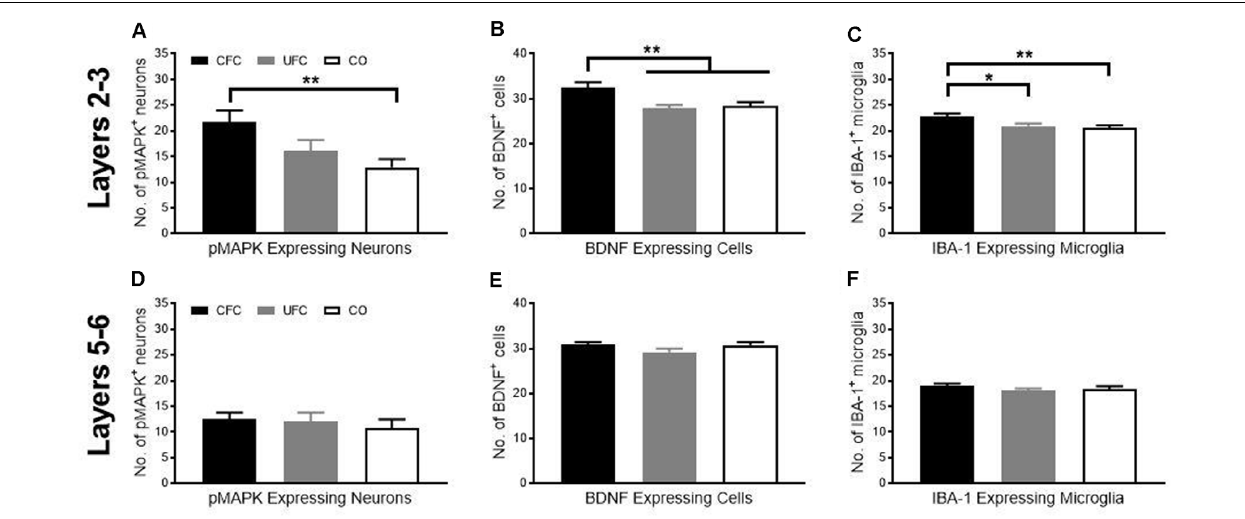
FIGURE 4 | pMAPK, BDNF and IBA-1 number in PL following CFC and UFC. Evaluation of pMAPK expressing neurons (A) in PL layer 2–3 revealed significant group differences to exist as a function of condition. Rats that underwent CFC had significantly more pMAPK expressing neurons as compared to rats in the CO control group. No further group differences were found. Similarly, evaluation of BDNF expressing cells (B) and IBA-1 labelled microglia (C) revealed group differences to exist as a function of condition. In both cases, rats in the CFC group had significantly more BDNF and IBA-1 labelled cells than both the CO control and UFC groups. In PL layer 5–6, rats that underwent CFC or UFC show no difference in (D) the number of pMAPK expressing neurons, (E) BDNF expressing cells and (F) IBA-1 labelled cells. PL, pre-limbic cortex; pMAPK, phosphorylated mitogen-activated protein kinase; BDNF, brain derive neurotrophic factor; IBA-1, ionized